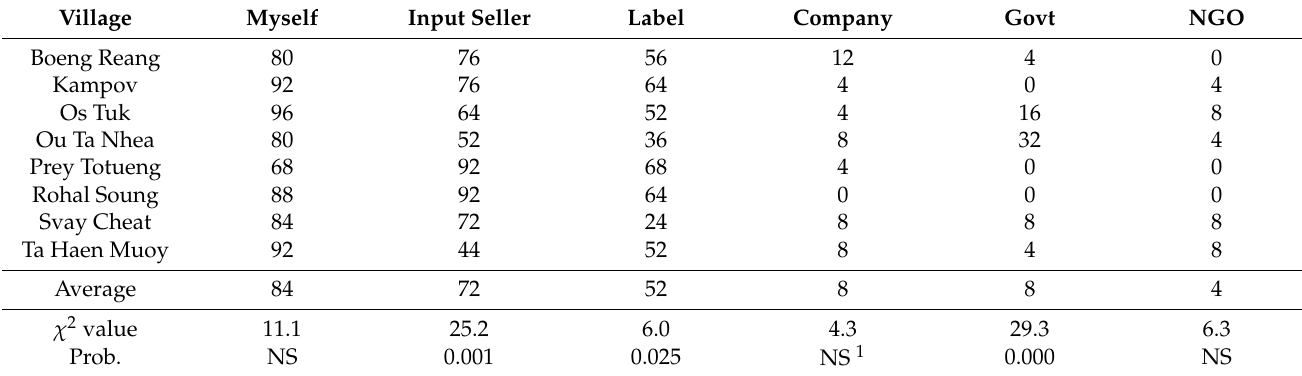
Table 8. Sources of information on herbicide use (% of households).